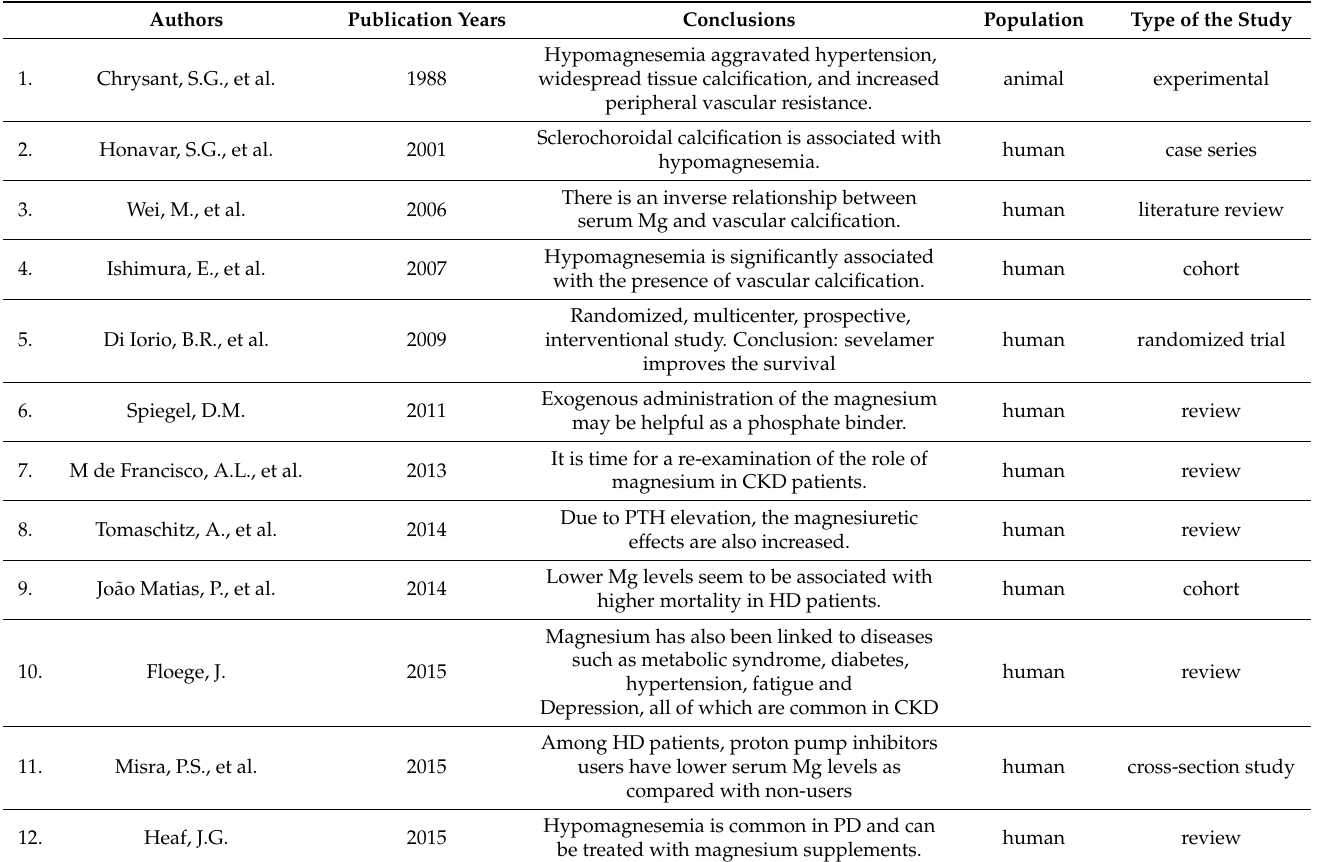
Table 3. The relevant references with the association between hypomagnesemia and vascular